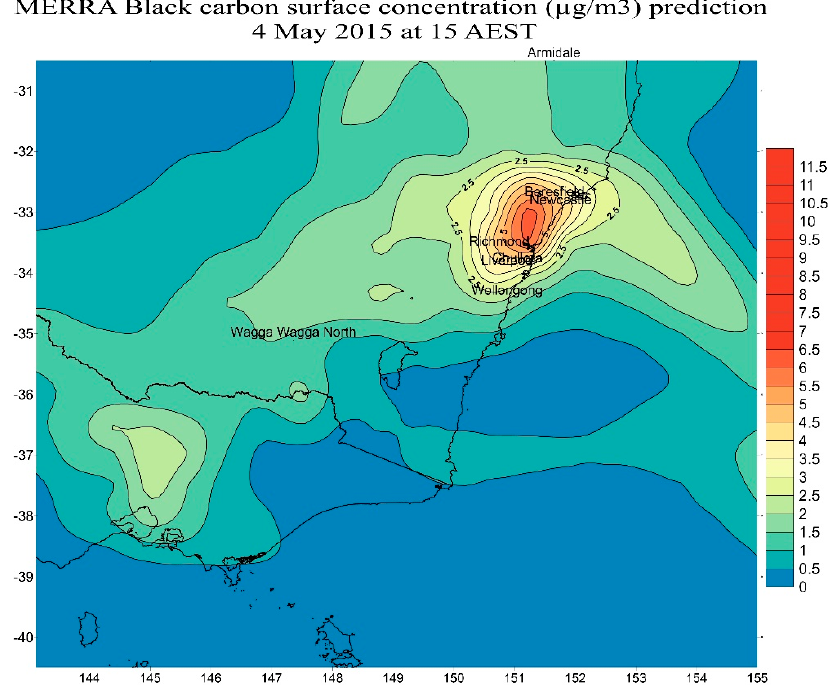
Figure 9. MERRA predicted black carbon surface concentration ( μ g/m 3 ) on 4 May 2015 at 15:00 AEST.